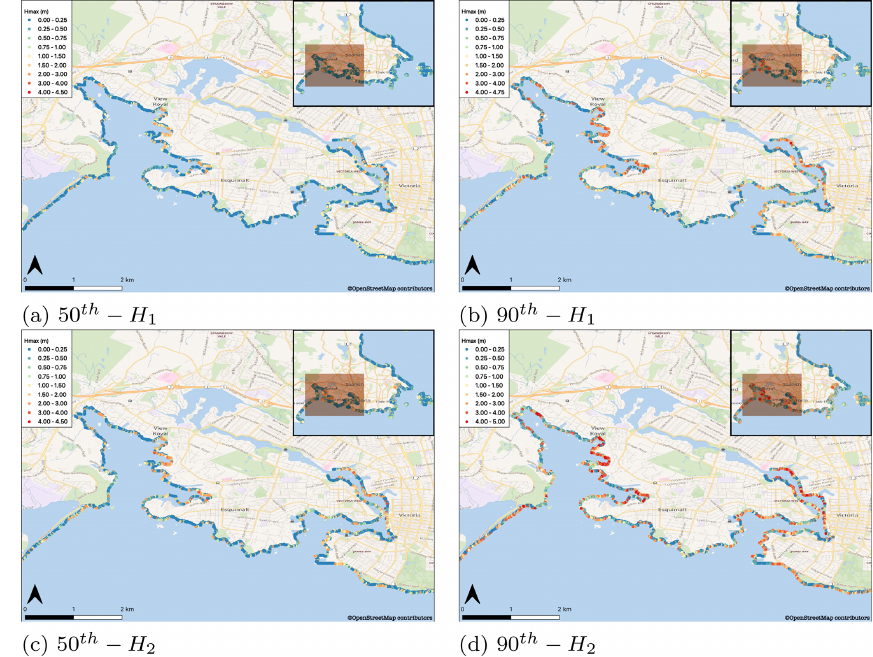
Figure 12. The percentiles (50th a , 90th b ) of the mean predictions at the cell centres of the computational grid, for buried ruptures (H1) and for splay-faulting (H2: 50th percentile c , 90th percentile d ). The circles show the locations of the emulators. The figures were produced with the QGIS software using as base maps the Wikimedia layers with data provided by © OpenStreetMap contributors, 2021. Distributed